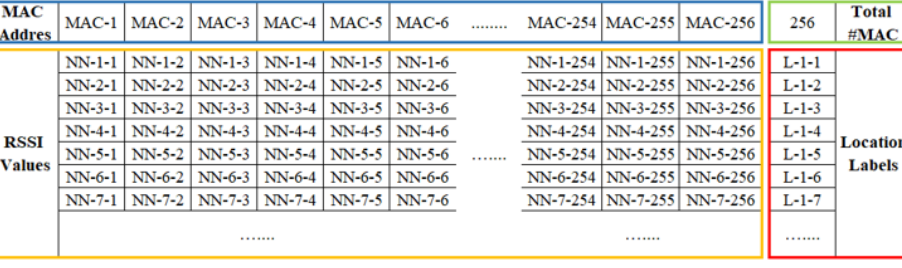
Figure 4. Input comma-separated-value (CSV) file format [14].